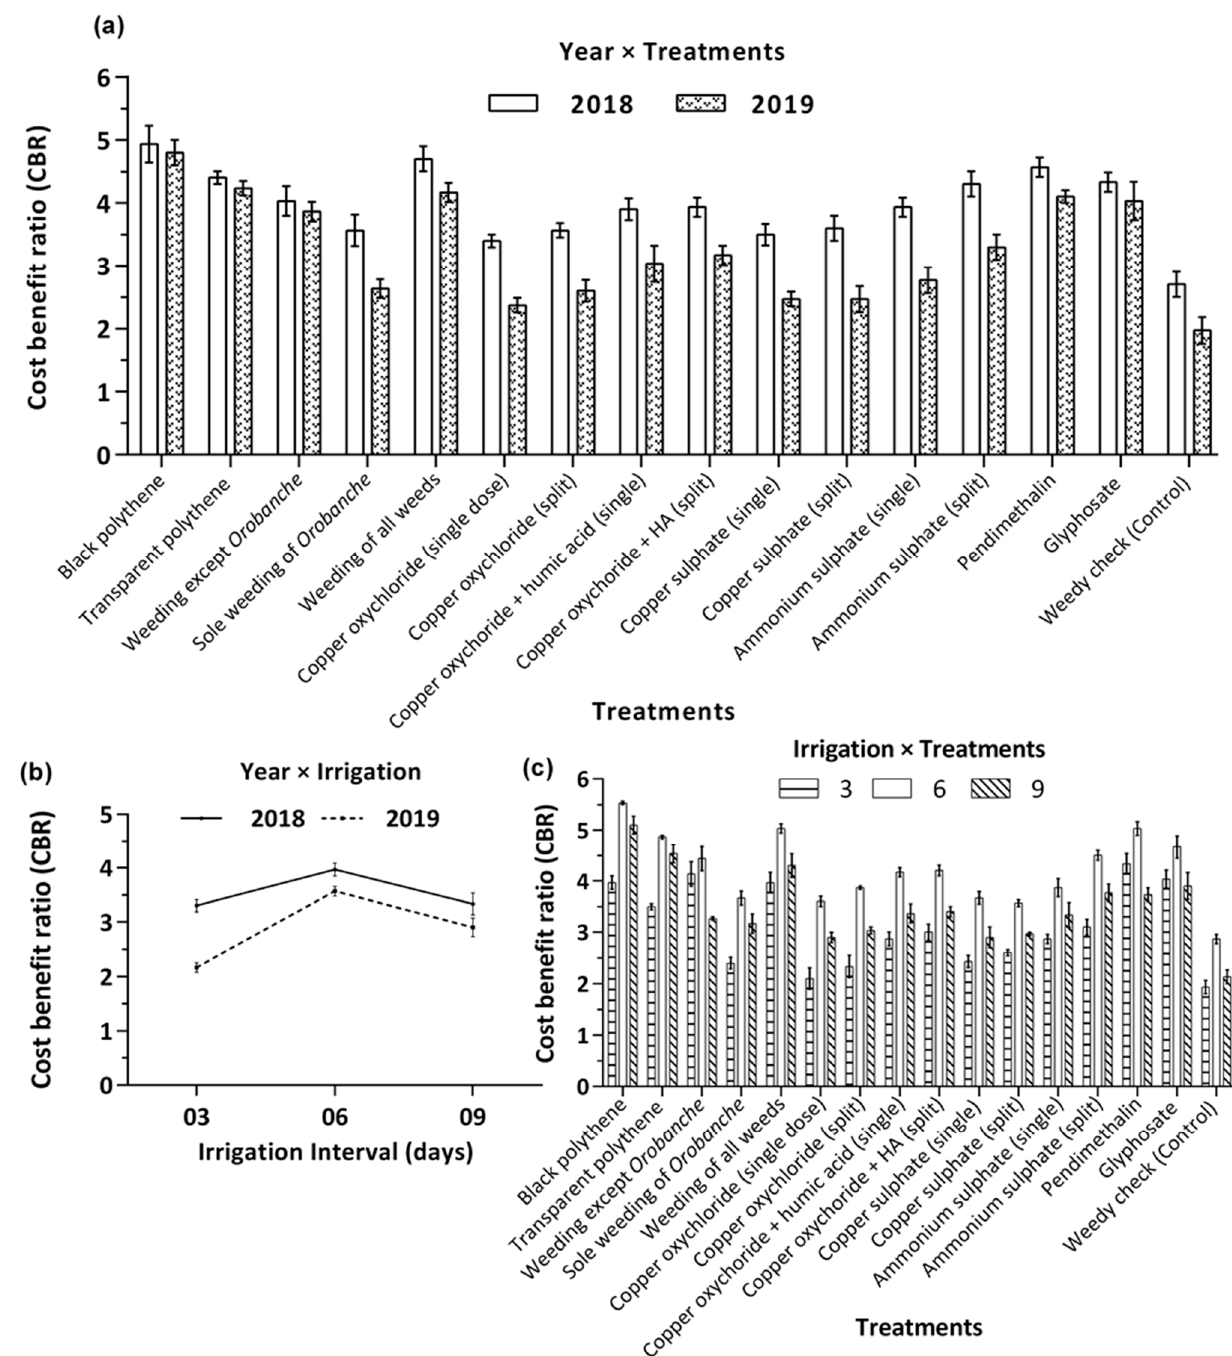
Figure 16. Impact of various interactions on cost/benefit ratio. ( a ) Interaction effect of year × treat- ments on CBR. ( b ) Interaction effect of year × irrigation on CBR. ( c ) Interaction effect of irrigation × treatments on CBR.